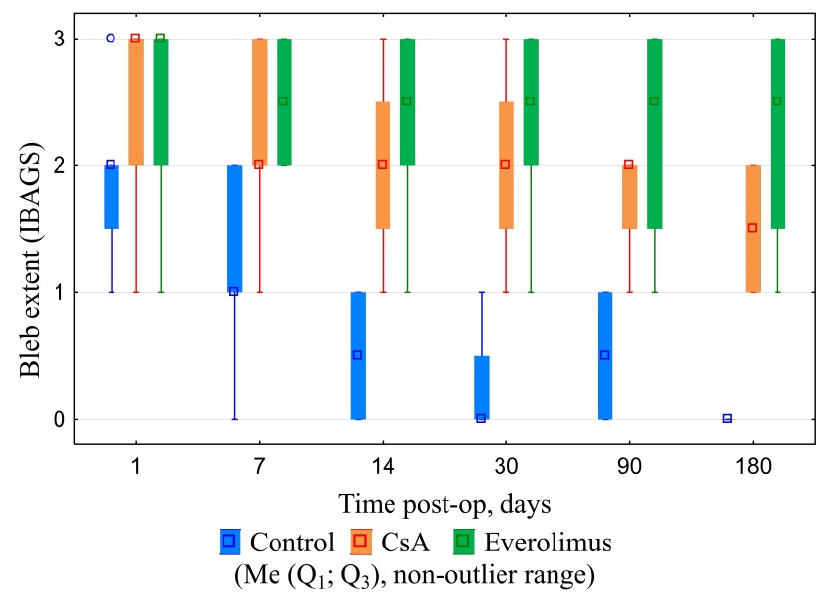
Figure 10. Blebs’ extent dynamics.